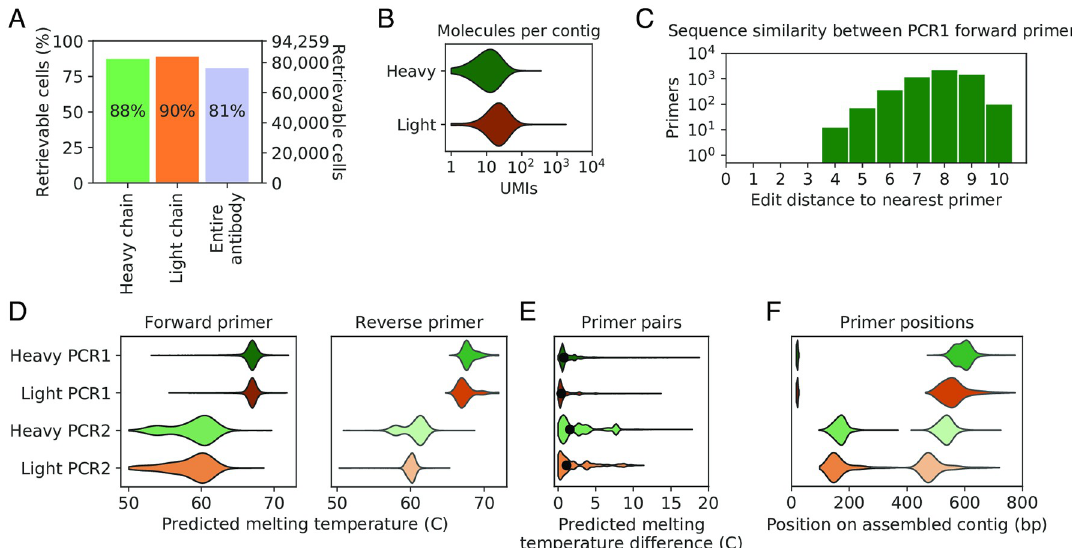
Fig 2. Computational design and characteristics of SPAR primers. (A) Success rates of SPAR primer design for heavy chain, light chain, and both chains for all cells in test dataset (n = 94,259 cells). (B) Number of cDNA molecules used to assemble each heavy- and light-chain contig (n = 94,259 heavy-chain contigs; n = 94,259 light-chain contigs). Each molecule carries a distinct unique molecular identifier (UMI). (C) Sequence similarity between PCR1 forward primers for all retrievable heavy-chain genes within one pooled library (n = 5,647 primers), as reflected in the distribution of edit distances to the nearest neighbor. Edit distance is defined as the number of insertions, deletions, or substitutions required to change one sequence to the other, also known as Levenshtein distance. (D) Predicted melting temperature of forward and reverse primers for all retrievable antibodies (n = 76,781). (E) Difference between predicted melting temperatures of forward and reverse primers in each pair for all retrievable antibodies (n = 76,781). Black dot indicates median. (F) Positions of forward and reverse primers for all retrievable antibodies (n = 76,781). Reverse primers are indicated by lighter shading, as in